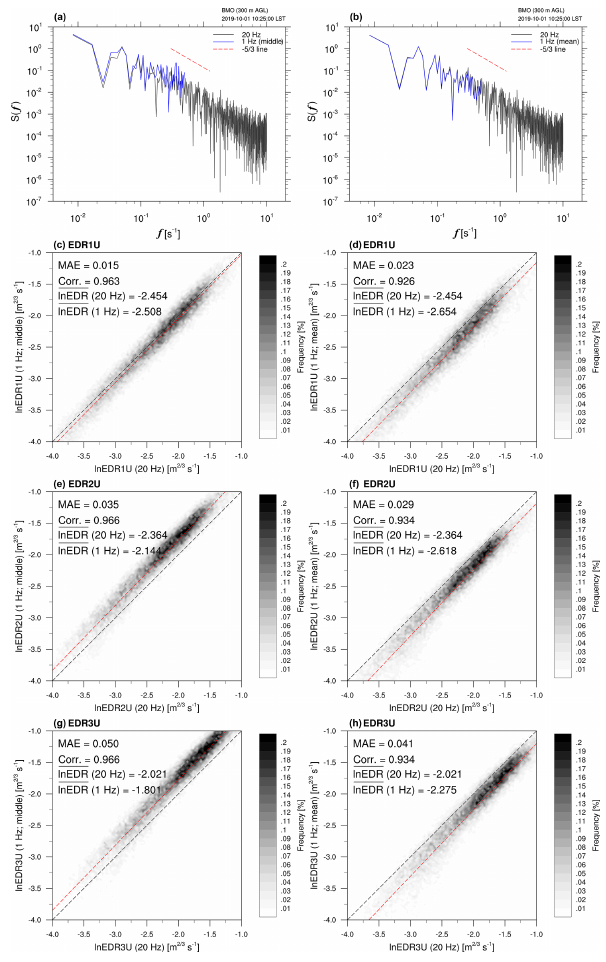
Figure 5. (a, b) The energy spectrum of the zonal wind compo- nent obtained from raw 20Hz (black) and subsampled 1Hz (blue) BMO data at 10:25LST on 1 October 2019 at 300ma.g.l. and (c– f) scatter density plots of the EDRs calculated using the 20Hz and subsampled 1Hz BMO data for early 10d from 00:00LST on 1 Oc- tober 2019. Pearson correlation, MAE, and mean of the natural log- arithm of EDRs calculated from 20 and 1Hz BMO data are given in the top-left corner of Figs. 5c–f. The 1Hz data are obtained by (a, c, e, g) picking every 10th sample from the raw 20Hz BMO data and (b, d, f, h) Reynolds averaging the raw 20Hz BMO data. The linear regression line is included as a red dashed line.